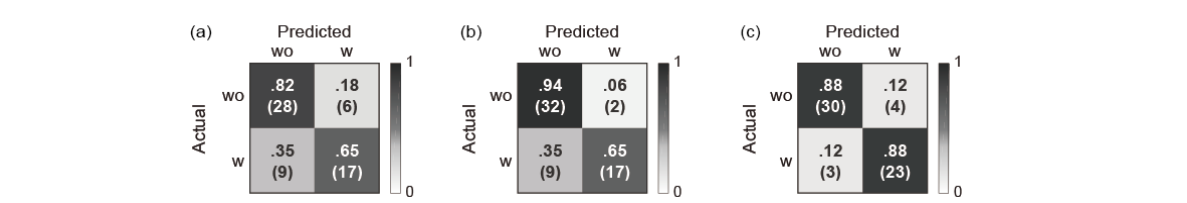
Figure 4. Confusion matrixes for predicting future accident risks of older drivers obtained using leave-one-subject-out cross-validation for models with (a) cognitive assessment variables, (b) speech features, and (c) cognitive assessment variables and speech features combined. The number in parentheses indicates the number of participants. wo: without; w: